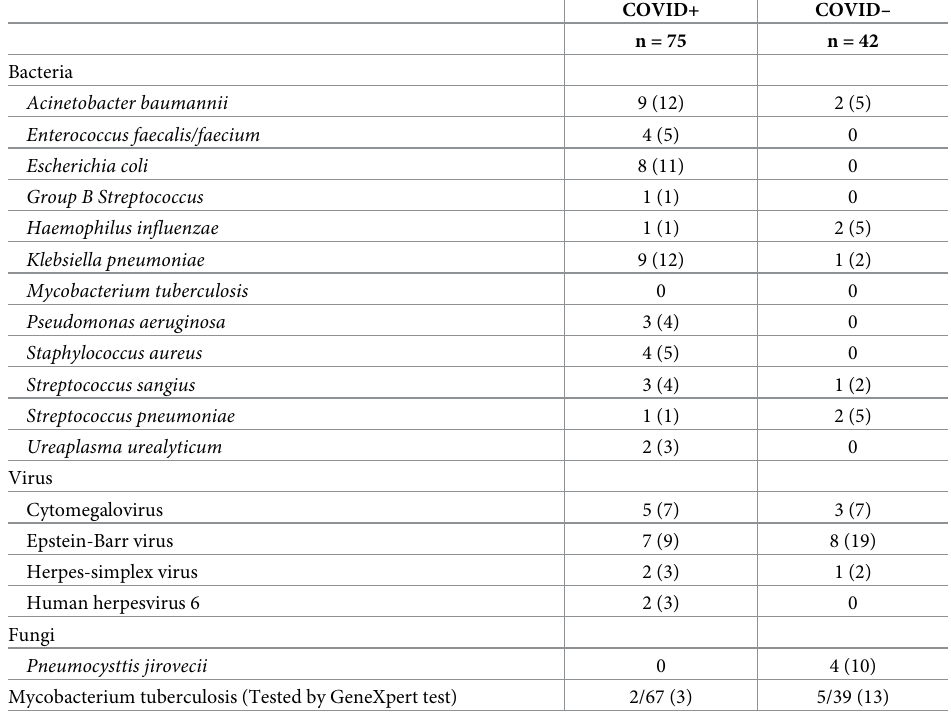
Table 4. Organisms identified on post-mortem lung molecular assay detection in decedents hospitalized with respiratory illness with (COVID+) and without (COVID–) SARS-CoV-2